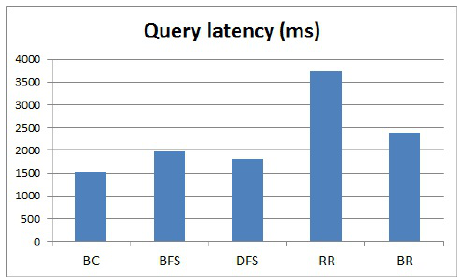
Figure 10. Query latency.